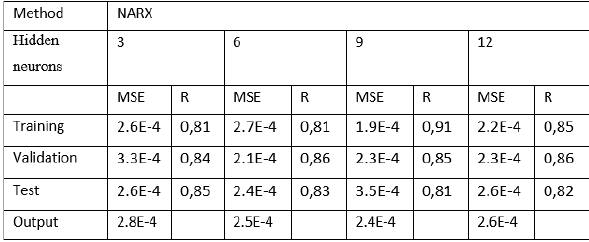
Table 4. Comparison of mean square error (MSE) and